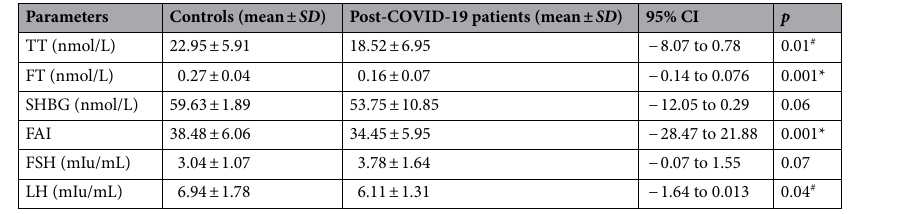
Table 2. Hormone differences between erectile dysfunction patients and controls. # p < 0.05, * p < 0.01. TT total testosterone, FT free testosterone, SHBG sex hormone-binding globulin, FAI free androgenic index, FSH follicular stimulating hormone, LH luteinizing hormone.